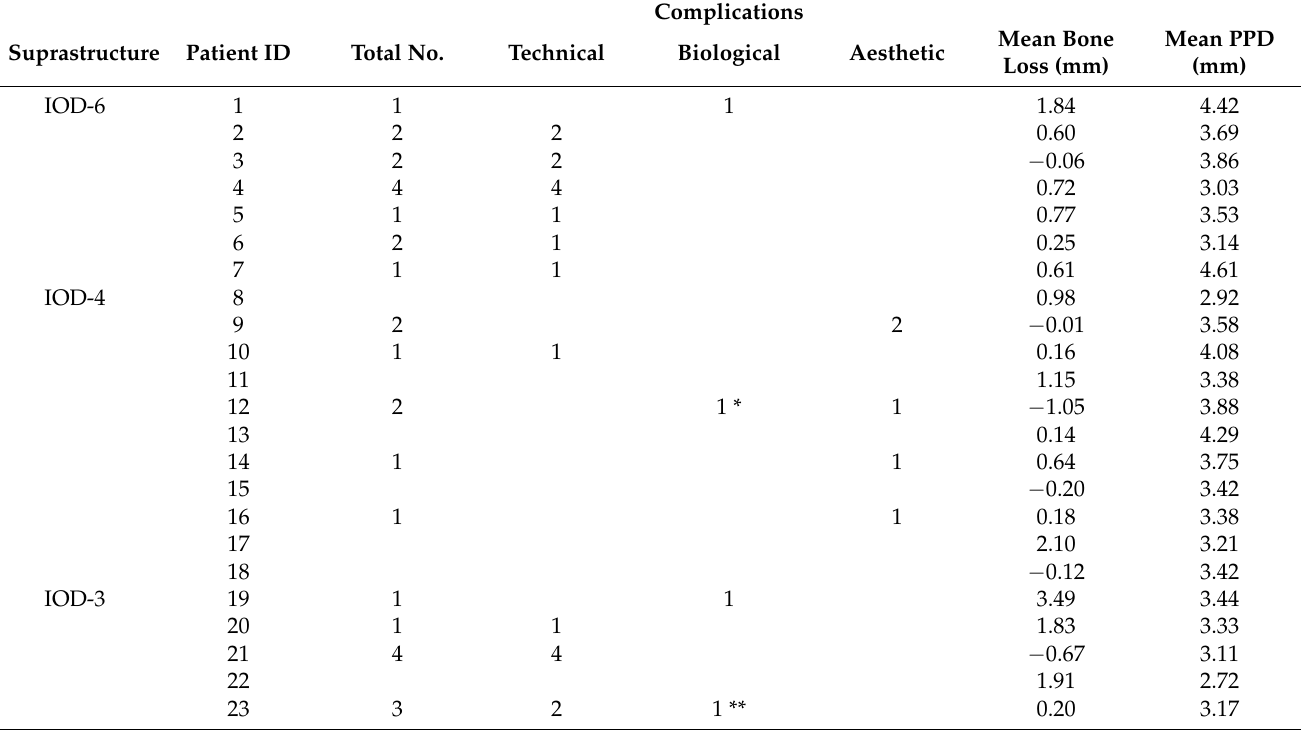
Table 4. Table showing distribution of all complications encountered per patient, per treatment group, at the time of follow-up, and corresponding mean bone loss (a negative number indicates bone gain) and probing pocket depth